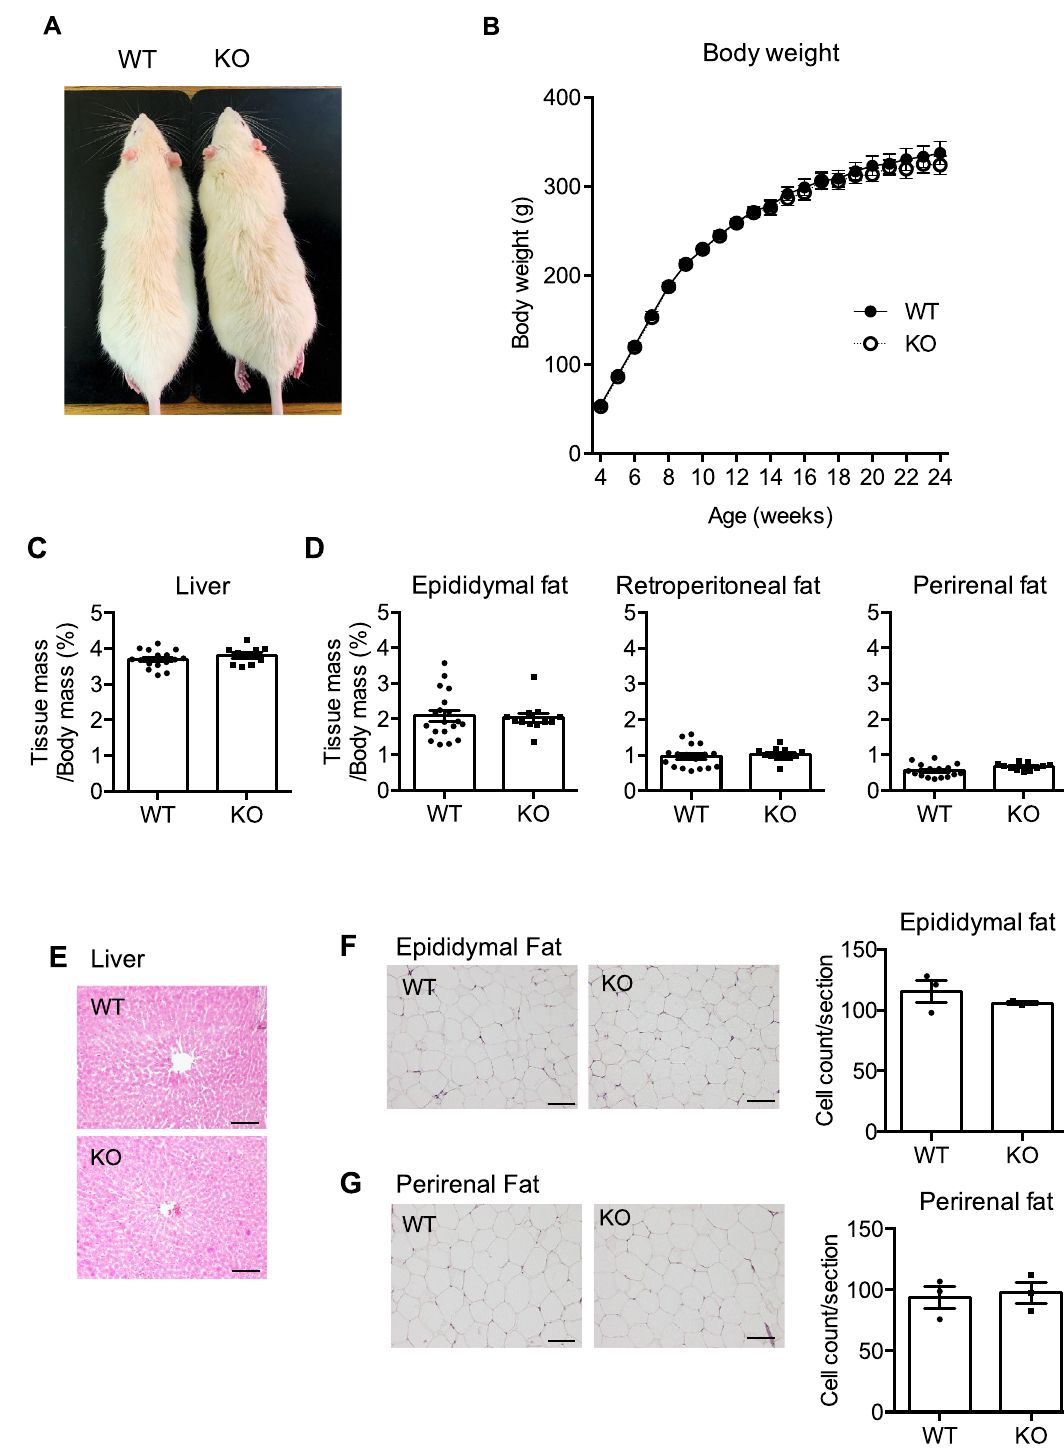
Figure 2. Body weight and adipose tissue mass of male WT and NMU KO rats fed normal chow. ( A ) Representative appearance of WT and KO rats (littermates) at 16 weeks of age. ( B ) Growth curve of WT and KO rats from 4 to 24 weeks of age (n = 15). ( C ) Percentage of the liver mass content in WT and KO rats (WT n = 16 KO n = 10). ( D ) Percentage of the visceral fat mass content in WT and KO rats (WT n = 19 KO n = 10). ( E ) Representative photographs of HE-stained liver sections of WT and KO rats. Scale bar: 100 µm. ( F ) Representative photographs of HE-stained sections of epididymal adipose tissue and the cell count per section (n = 3). Scale bar: 100 µm. ( G ) Representative photographs of HE-stained sections of perirenal adipose tissue and the cell count per section (n = 3). Scale bar: 100 µm. All data represent means ±